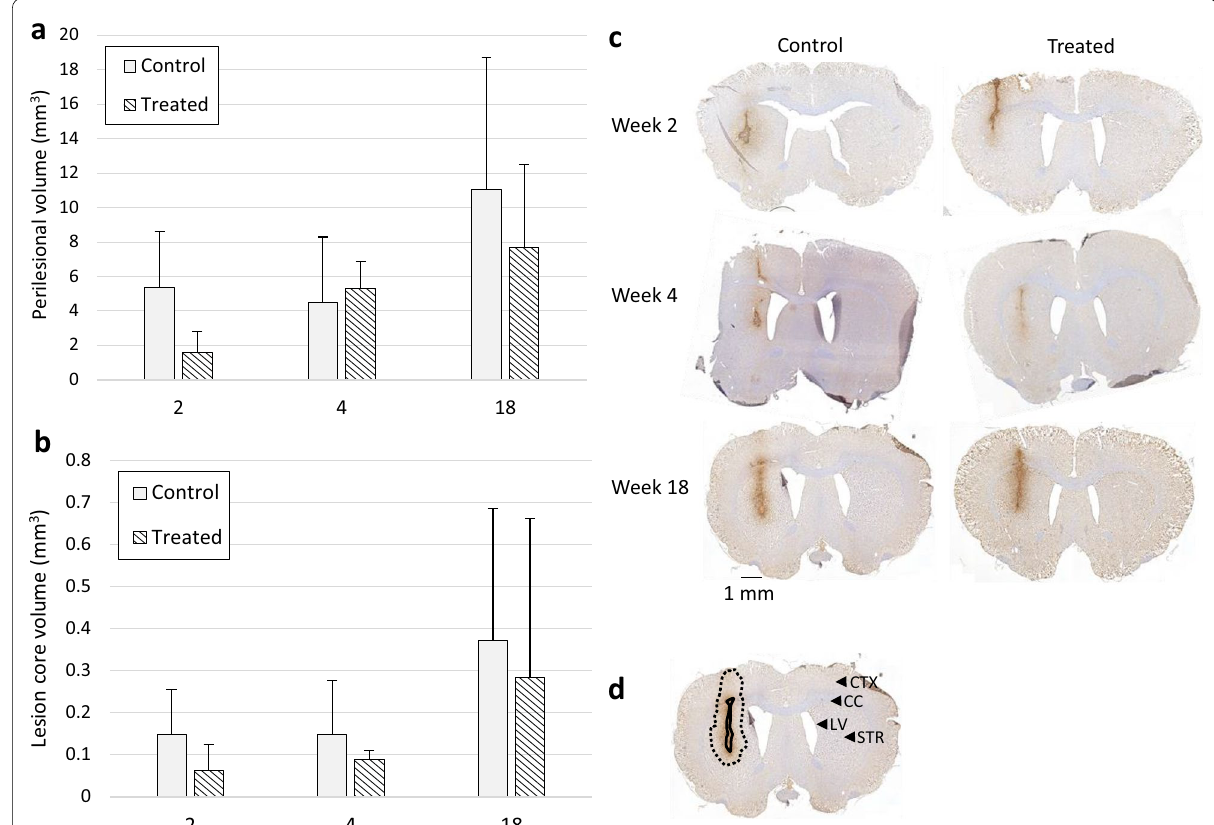
Fig. 4 Immunohistochemical staining against Iba1 in weeks 2, 4, and 18. Nuclei are counterstained with haematoxylin. a , b The volume was determined semi‑quantitatively by calculating the area of activated microglia at 100‑µm intervals and extrapolating the area in between using the trapezoidal rule. a The perilesional volume (mm 3 ) of the lesion and b the lesion core volume were calculated as an average for both the control and treated animals. No differences were detected at any time points between the treated and control animals. The results are presented as mean (SD). c Representative images of the control and treated animals in weeks 2, 4, and 18. Scale bar 1 mm. d A representative image of the lesion core = (solid black line) and perilesional area (dotted black line) delineation of the week 18 control animal. The lesion core indicates the infiltrative core area of the lesion with high Iba1 staining. The perilesional area is a subjective estimate of the area that has increased diffuse microglial activation higher from the contralateral staining but less prominent as the lesion core. In addition, the prominent brain regions visible on the coronal sections have been indicated on the contralateral side by using arrow‑heads. CTX cortex, LV lateral ventricle, CC corpus callosum, STR